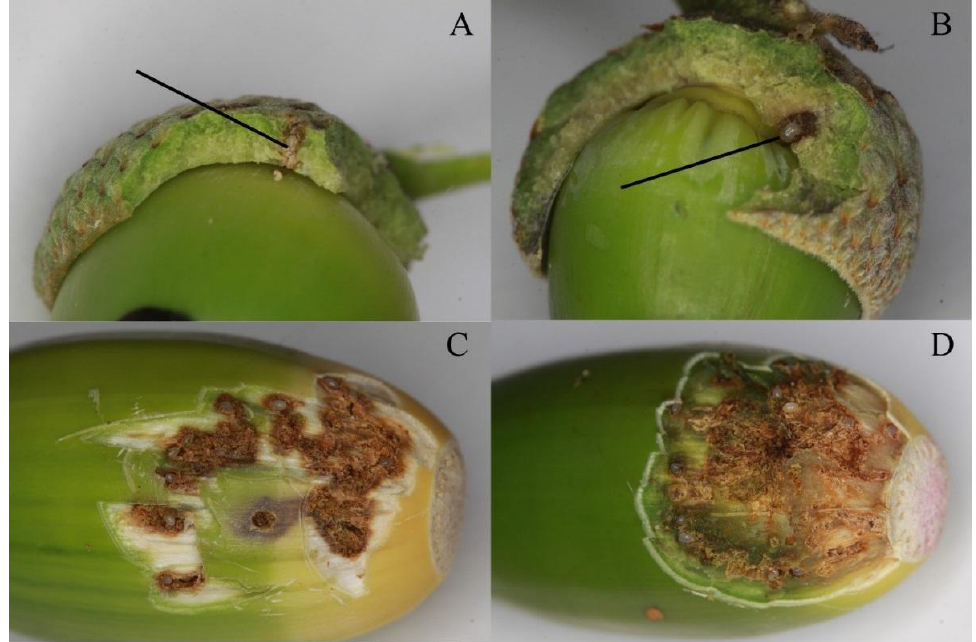
Figure 3. Typical view on oviposition sites in acorns infested during the first experiment: ( A , B ) C. venosus ; ( C , D ) C. glandium . Curculio venosus usually lays one egg per acorn (marked with an arrow), always into cupula. Contrary, C. glandium can oviposit few (even 10 or more) eggs into one acorn, just below the outer skin, and not into the cupula.